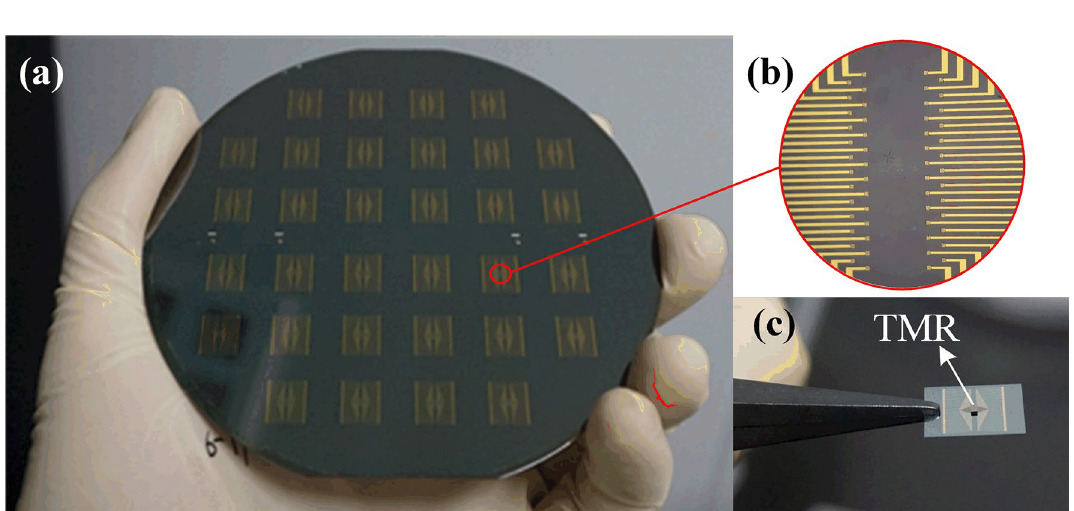
Figure 4. ( a ) Photograph of the fabricated 4-inch silicon wafer. ( b ) Micrograph of the bonding pads (Created by Microsoft Visio 2013 (15.0)). ( c ) Image of wafer-level Au-In bonding with